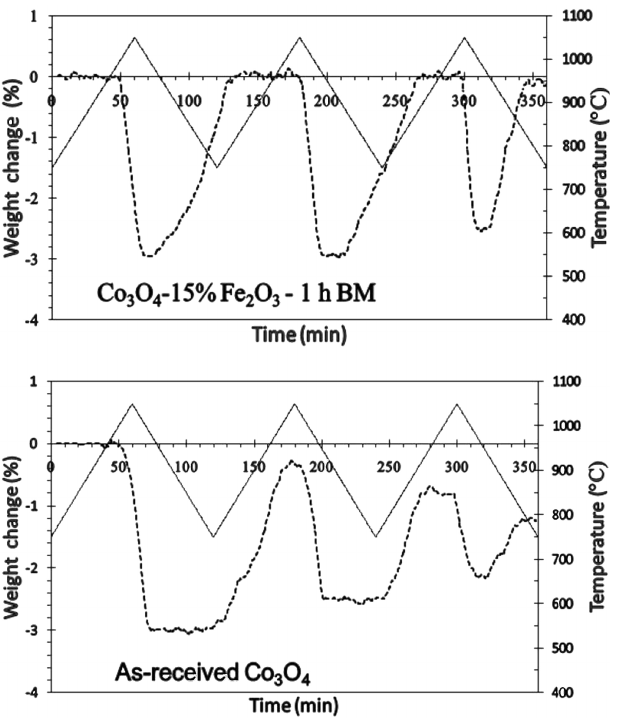
Fig. 8. Cyclability of as-received Co 3 O 4 and 1 h ball milled Co 3 O 4 - 15 wt% Fe 2 O 3